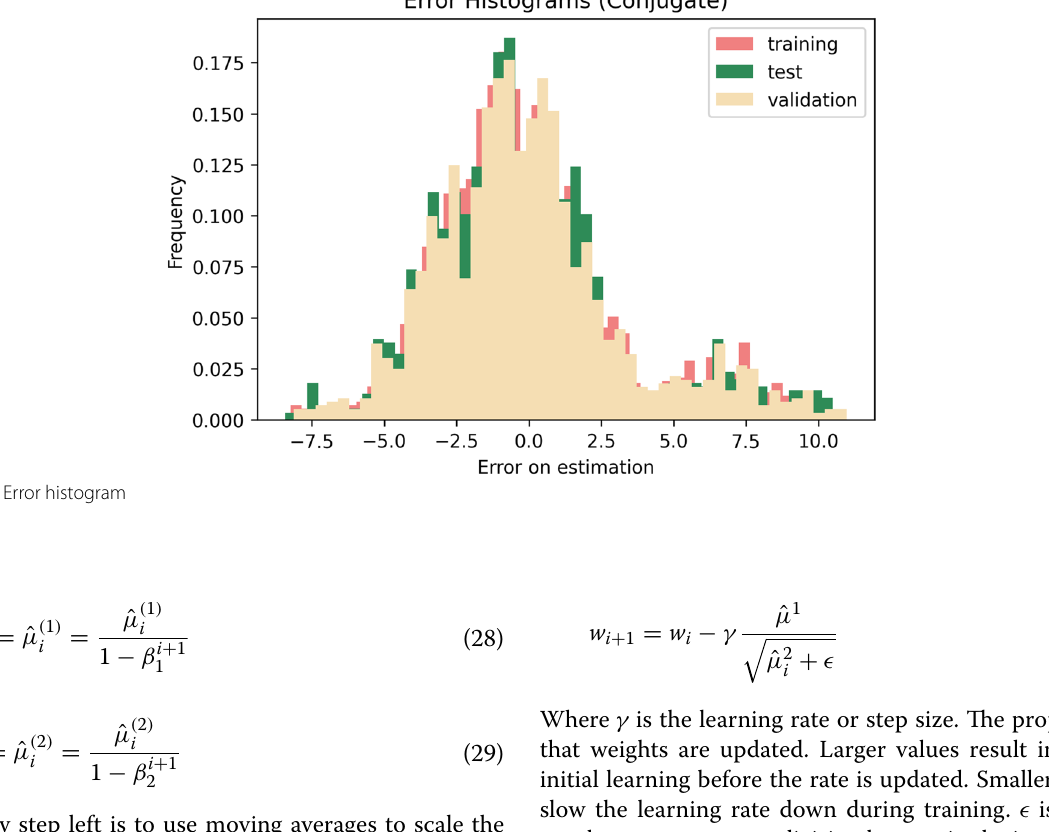
The only step left is to use moving averages to scale the learning rate individually for each parameter. w is calcu- lated by Eq.